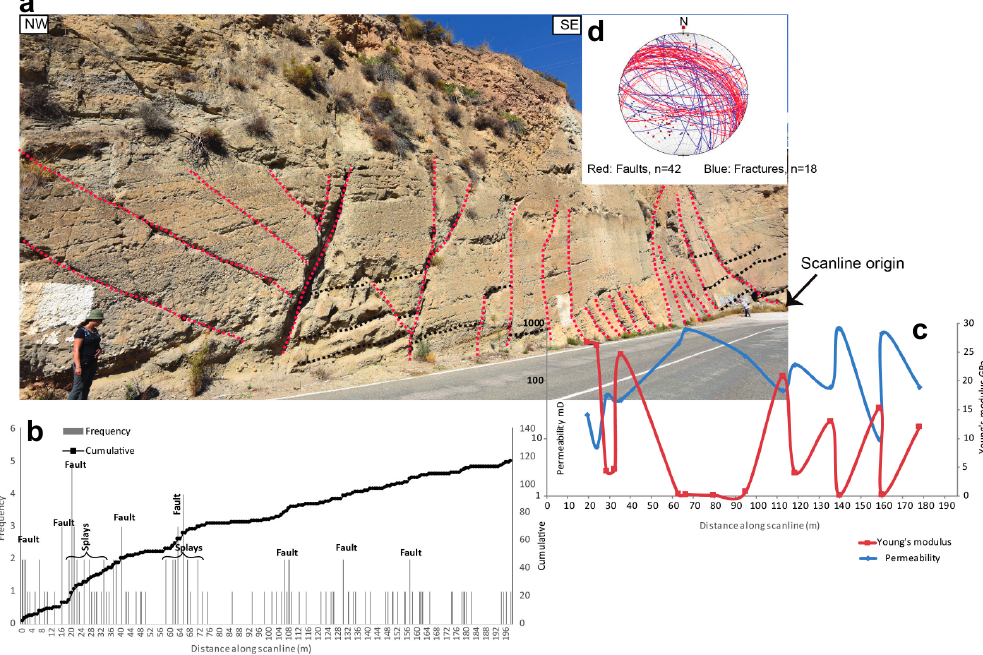
Figure 14. ( a ) Section in the Tablate A locality in the southeastern edge of the Granada Basin. Several small normal faults (red dashed lines) located in the damage zone of a segment to the S of the Padul Fault have been measured along the scanline. Layering is shown in black dashed lines. ( b ) The fracture frequency and cumulative distribution shows an increase in the number of fractures from an average background fractures (1 fracture per meter) where the small faults are located. ( c ) Permeability and Young’s modulus measurements along the scanline. ( d ) Stereoplots showing the orientation of faults and fractures in this locality.